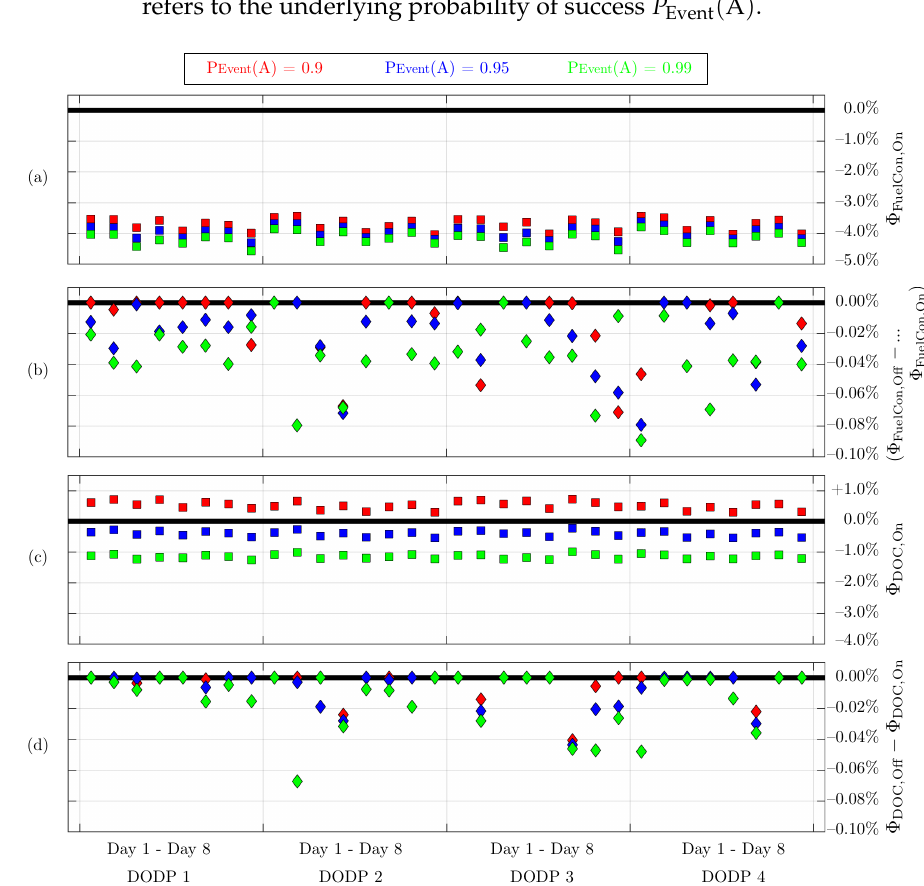
Figure 4. Expected potential Φ of unprotected actions compared to protected actions with regard to ( a ) reduction in fuel consumption for on-track decision points; ( b ) additional reduction in fuel consumption for off-track decision points; ( c ) reduction in C DOC for on-track decision points; ( d ) reduction in C DOC for off-track decision